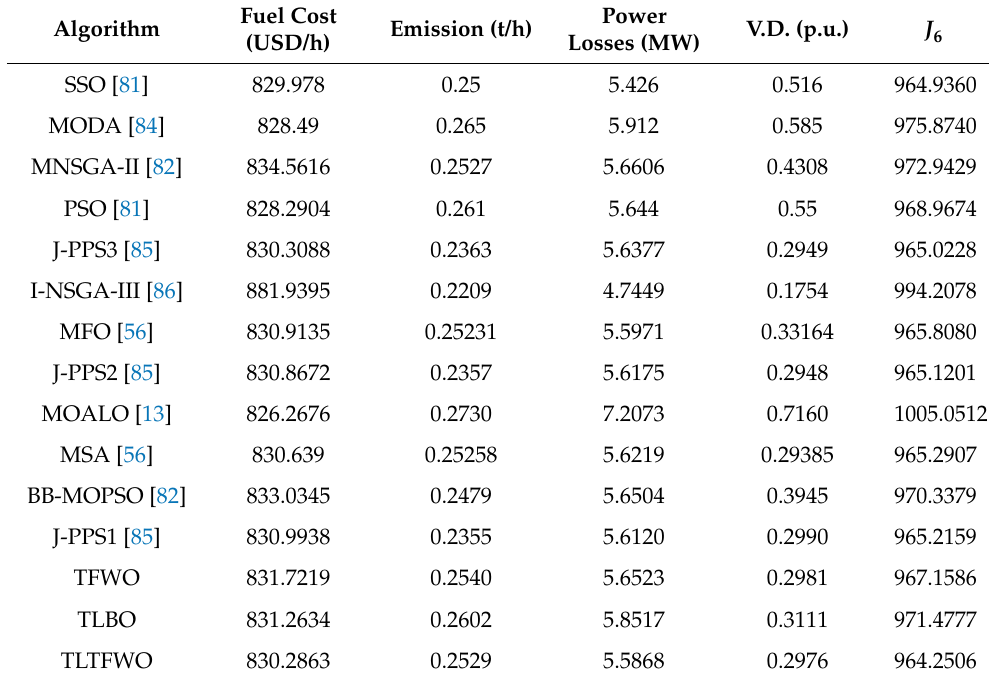
Table 9. Optimal results of the present study in Case